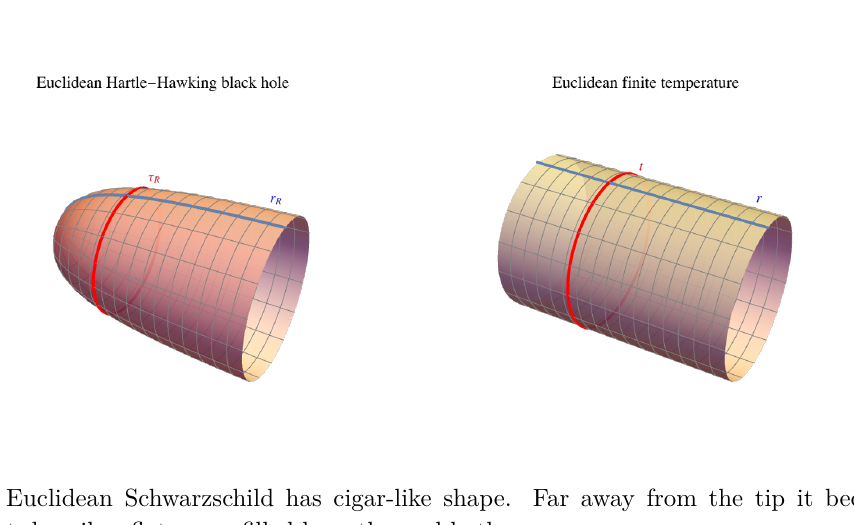
Figure 2 . Euclidean Schwarzschild has cigar-like shape. Far away from the tip it becomes a cylinder, that describes flat space filled by a thermal bath. The limit R (cid:28) R considered in the previous section 3 corresponds to a sph BH